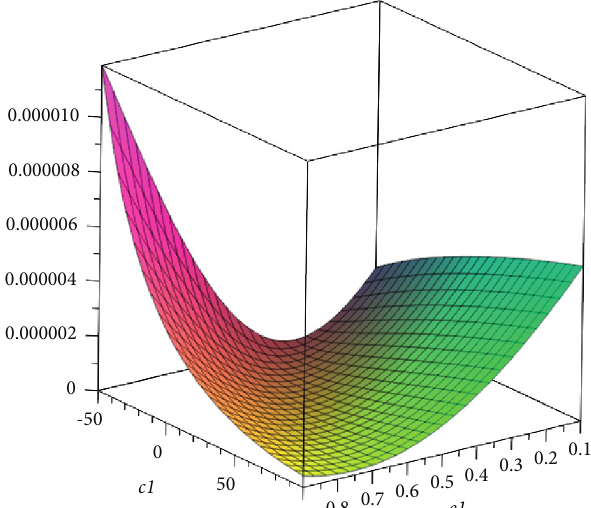
Figure 16: The graph of the function G e ≤ 0 . 9 and − 50 ≤ c 1